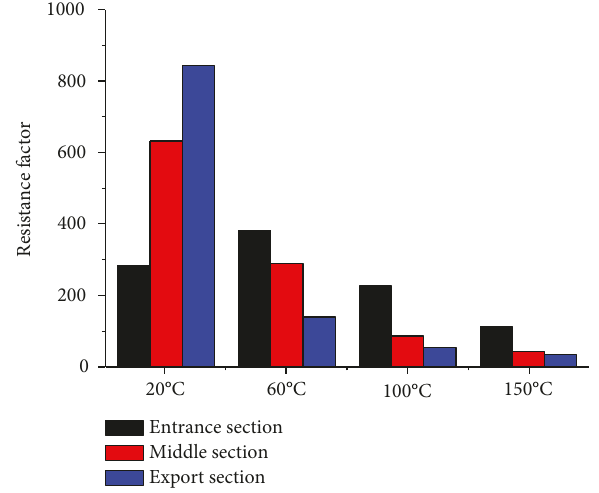
Figure 6: Comparison of the resistance factors on di ff erent sections at di ff erent temperatures.